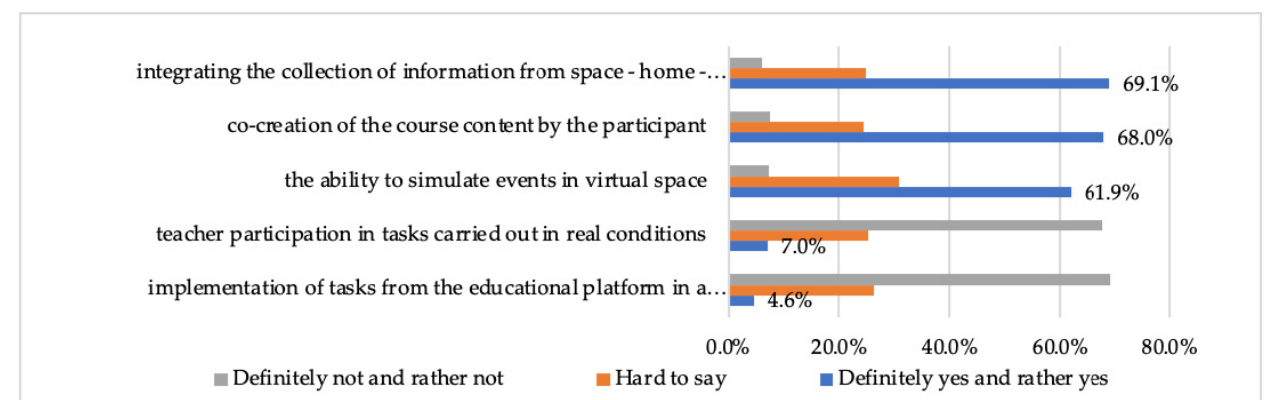
Figure 2. Smart learning representation.